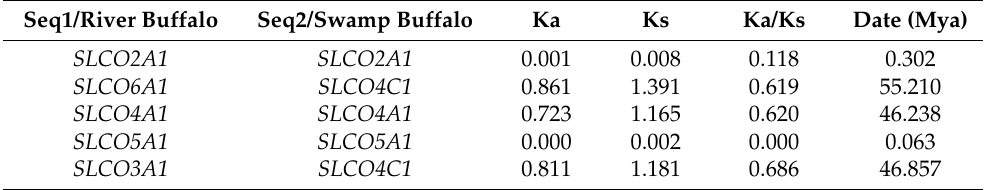
Table 3. The Ka/Ks ratios and divergence times for each pair of orthologous OAT genes in buffalo. Seq1/River